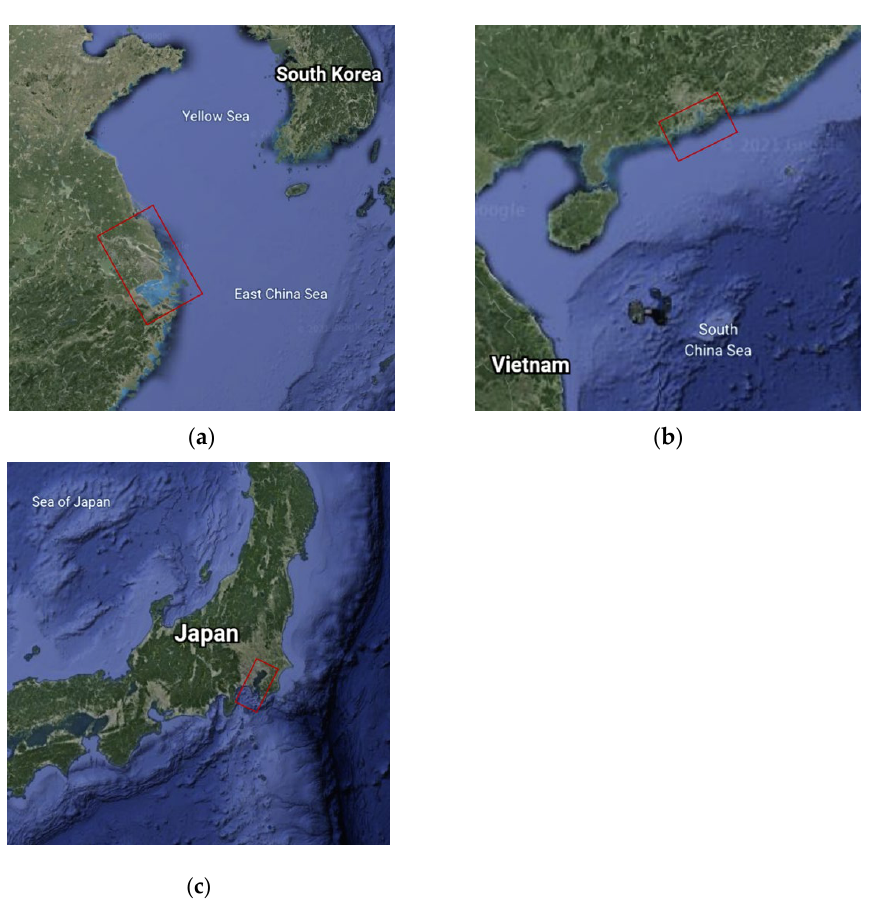
Figure 1. Coverage of the original images of GF-3: ( a ) Nanjing Changjiang River and Zhoushan Port; ( b ) Hong Kong and Macao; ( c ) Yokohama Port.